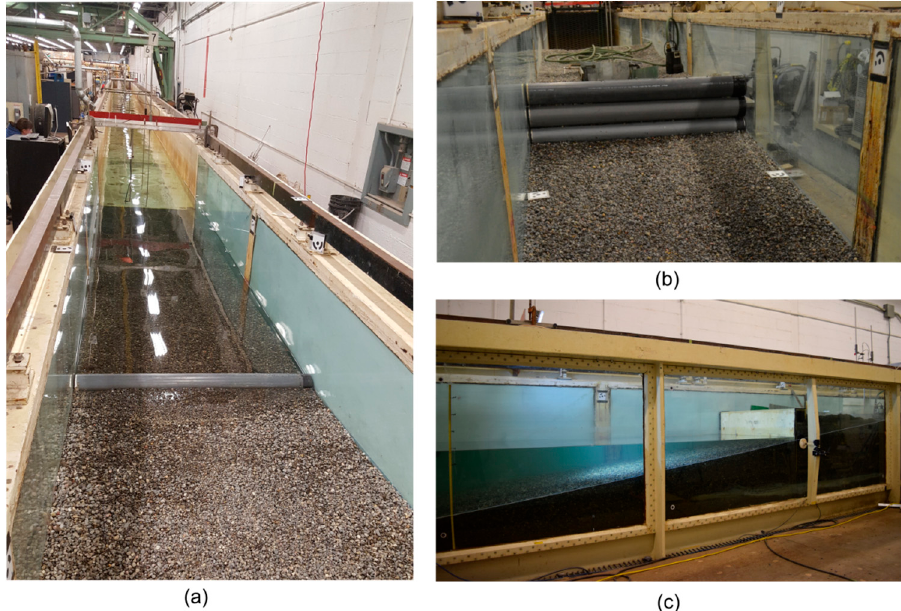
Figure 2. Experimental setup of gravel beach and instrumentation in steel flume with ( a ) model log made out of a PVC pipe with expandable end for the Single configuration, ( b ) three stacked model logs for the Stacked configuration and ( c ) a vertical plywood seawall at the SWL for the Seawall test configuration. Table 1. Overview of test runs and associated parameters, used in this